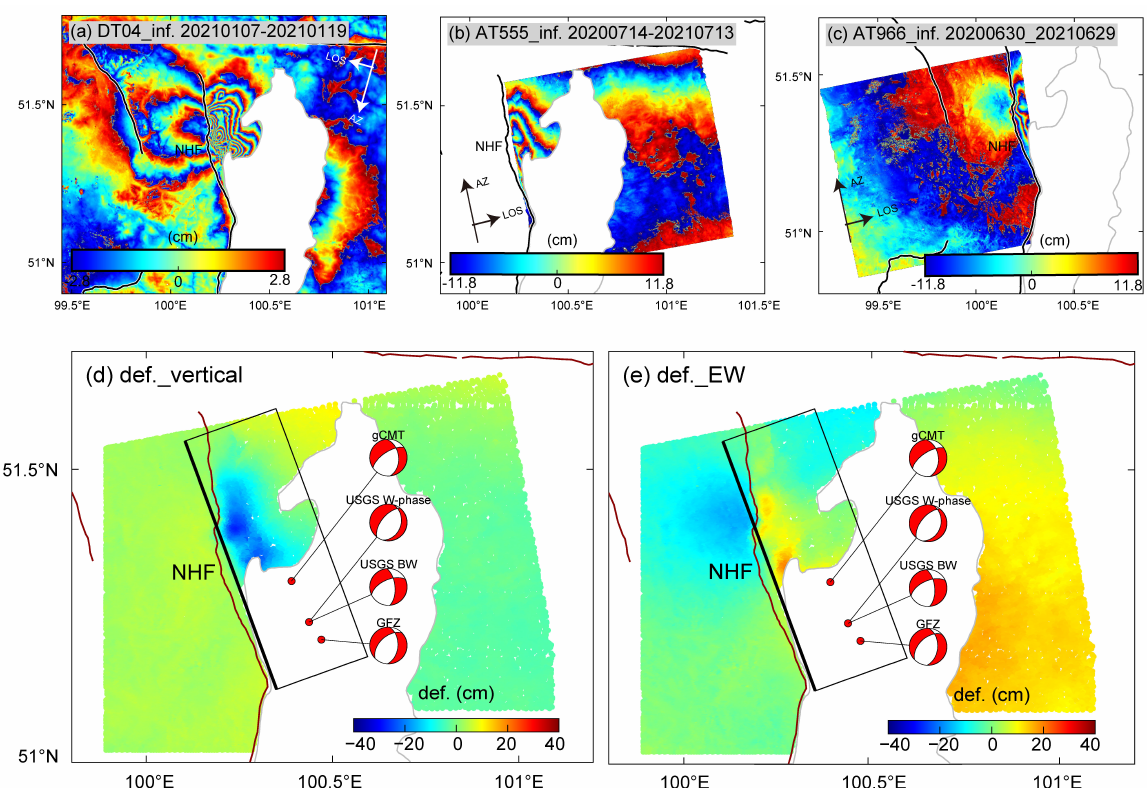
Figure 2. Surface deformation associated with the 2021 Mw6.7 Lake Hovsgol earthquake obtained from Sentinel-1 and ALOS-2 SAR satellites. The water body was masked out manually. ( a – c ) In- terferograms from descending Sentinel-1 (DT04) and ascending ALOS-2 (AT555 and AT966) tracks, respectively. Each fringe represents 2.8 cm for Sentinel-1 and 11.8 cm for ALOS-2 interferograms, respectively. ( d , e ) Vertical and east–west horizontal displacements computed using the observations in ( a – c ). The reddish color indicates the uplift/eastward movement, while bluish color is subsi- dence/westward movement. The black rectangle represents the surficial projection of our fault model. The beachballs display focal mechanisms of the Mw6.7 event from different institutions as